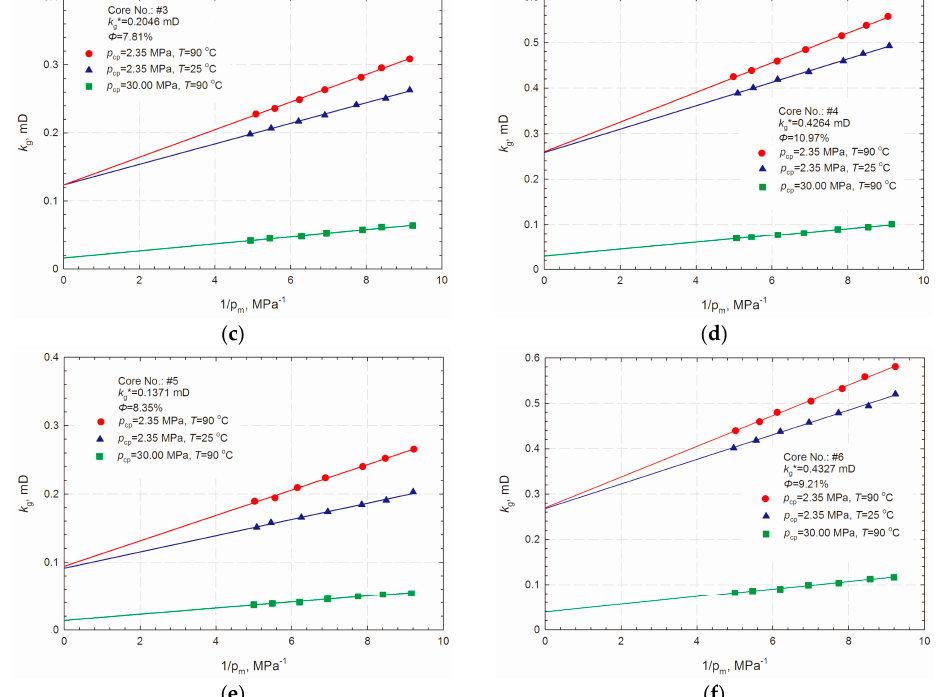
Figure 4. Experimental results of Klinkenberg correction for core samples: ( a ) #1; ( b ) #2; ( c ) #3; ( d ) #4; ( e ) #5; ( f ) #6.